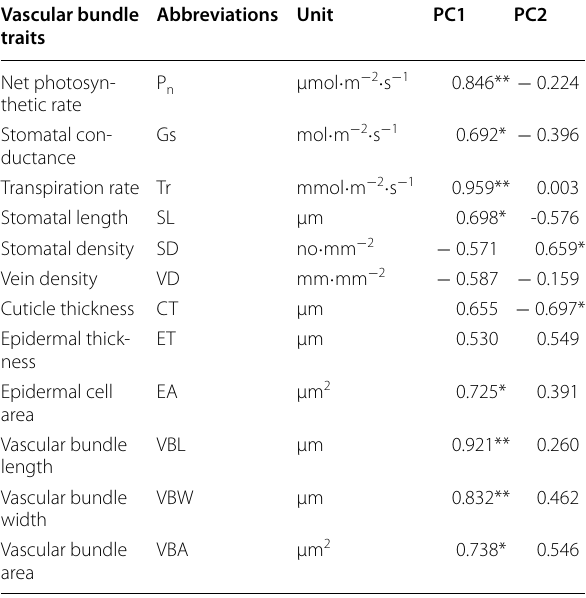
measured in this study and the results of principal components